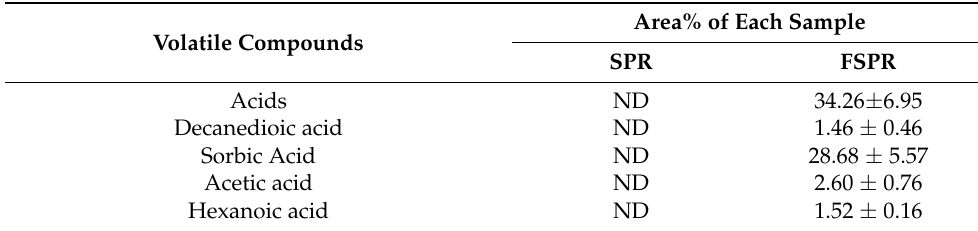
Table 2. The relative abundance of volatile components in the sweet potato residues fermented with combined